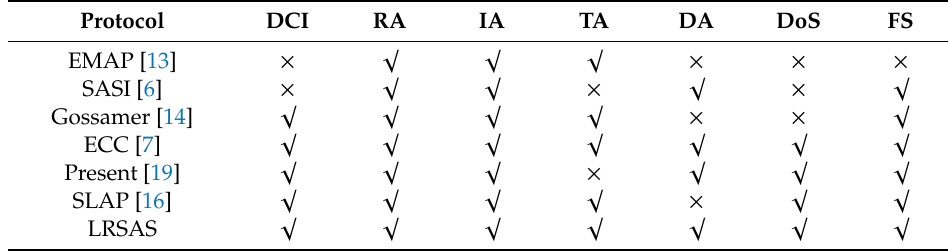
Table 4. Security